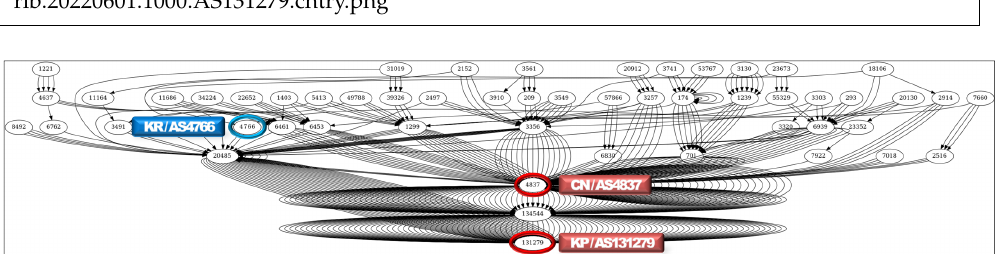
Figure 9. Di-graph visualization of BGP network topology between North Korea and China.